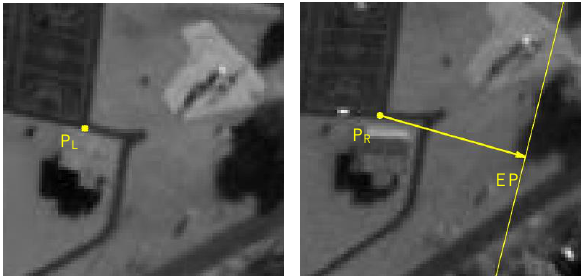
Figure 2. Relative pointing